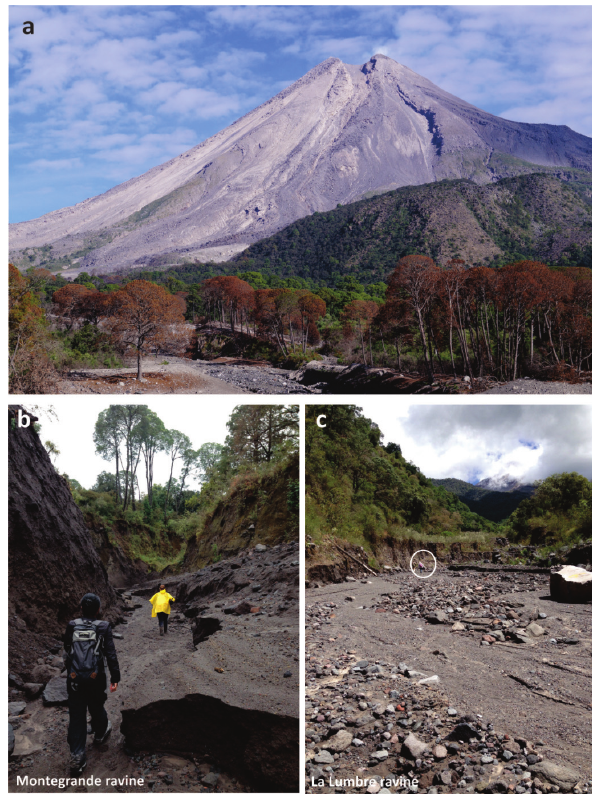
Figure 2. (a) Panoramic view of the Volcán de Colima showing the unvegetated main cone mostly composed of loose volcanic frag- ments. (b) Montegrande and (c) La Lumbre ravines in the middle reach, where it is possible to observe the main channel flanked by 10–15m high terraces mainly constituted by debris avalanche de-